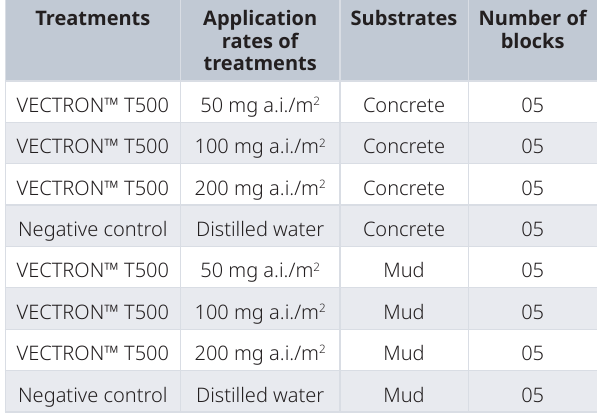
Table 1. Substrates and treatments used for laboratory